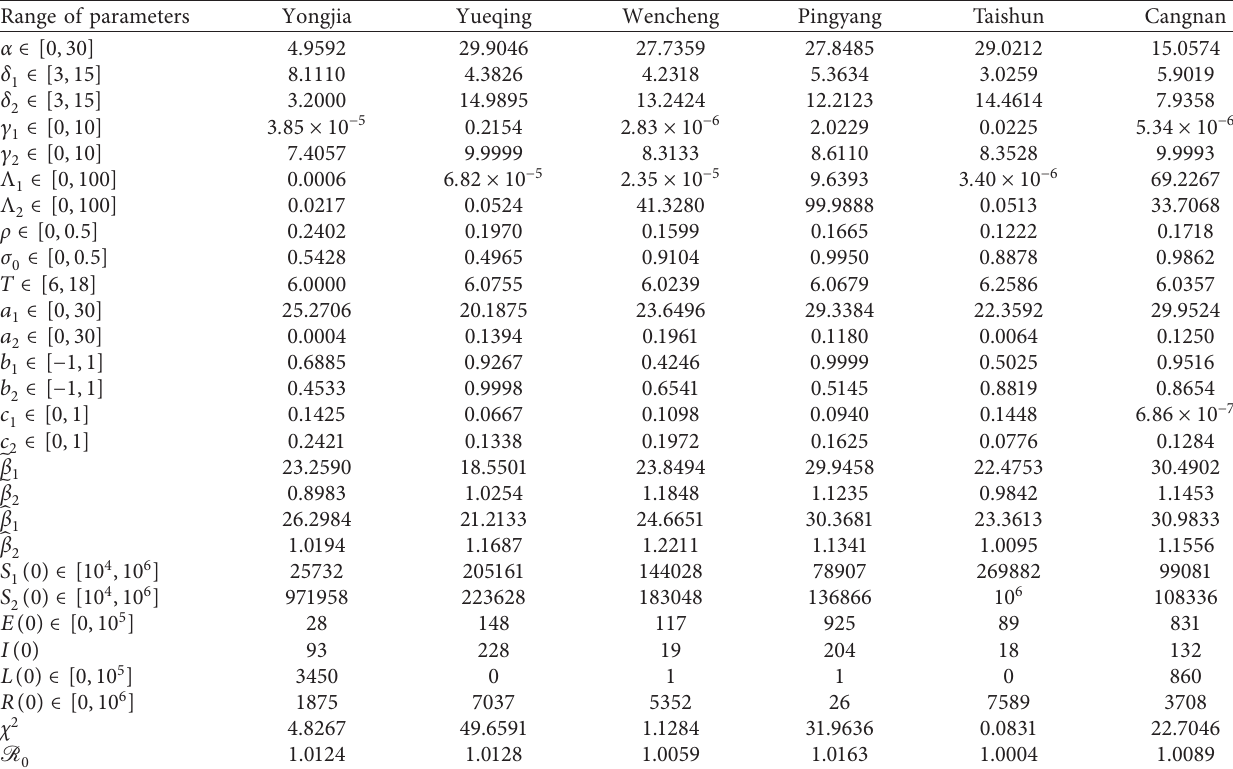
Table 2: Parameters and their